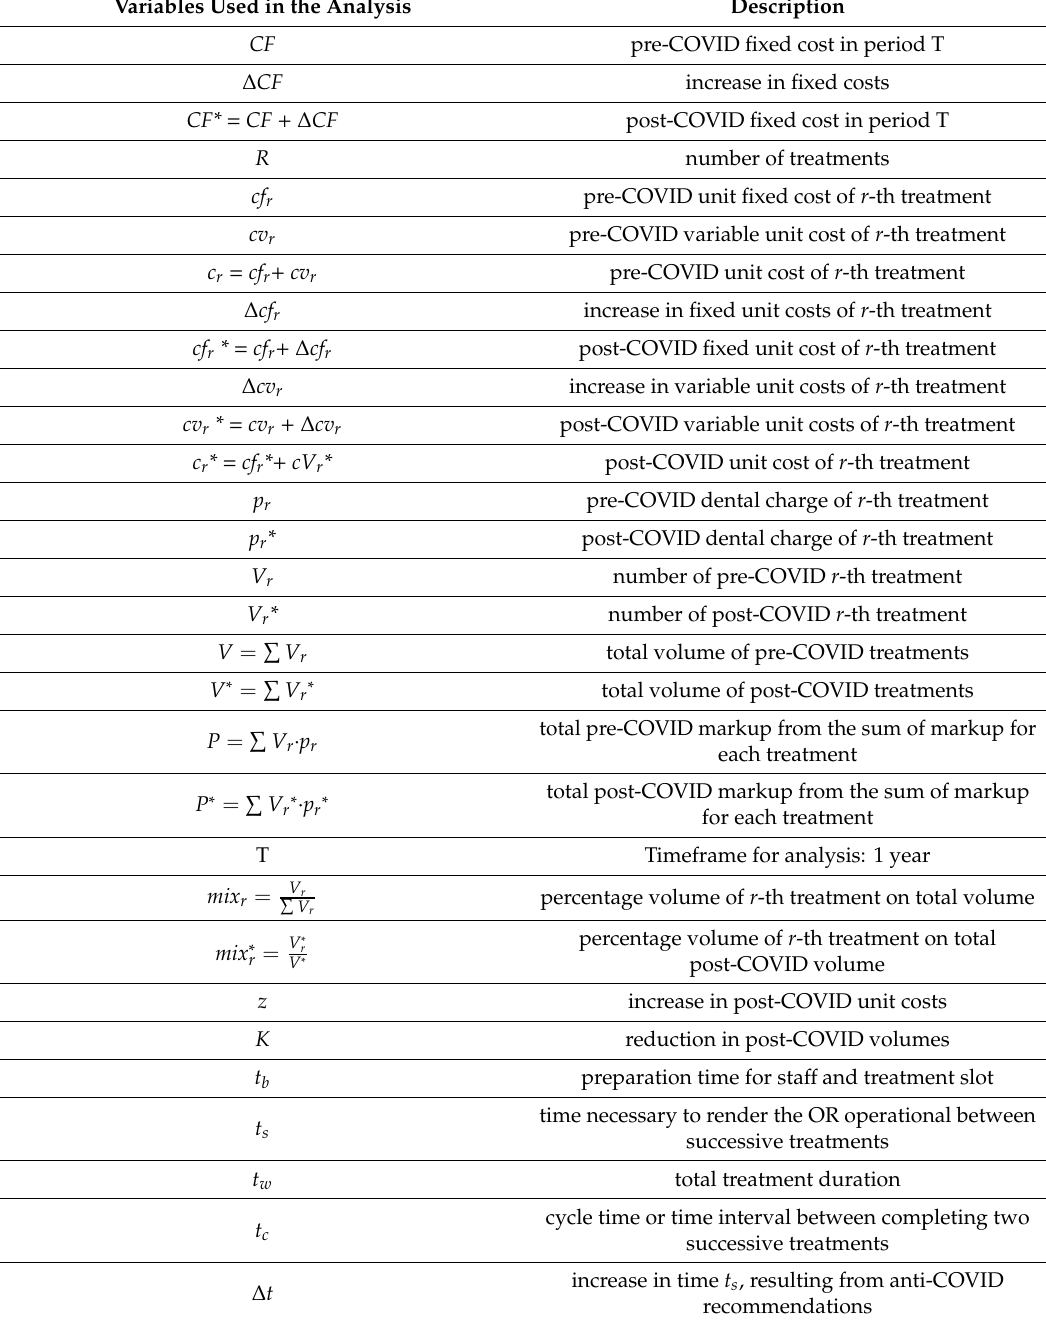
Table A1. Variables used in the analysis. The symbol attributing all possible values to r ( r varies from 1 to R in this